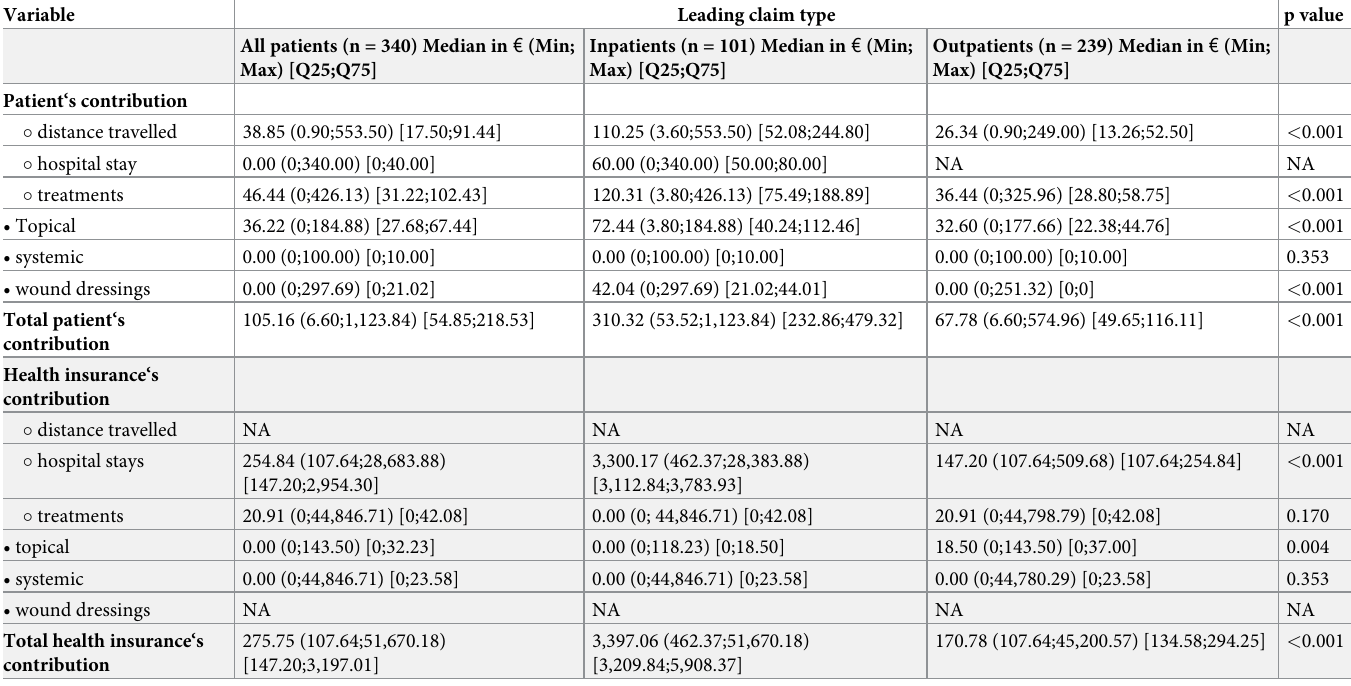
Table 5. Patient‘s contribution and costs of the statutory health